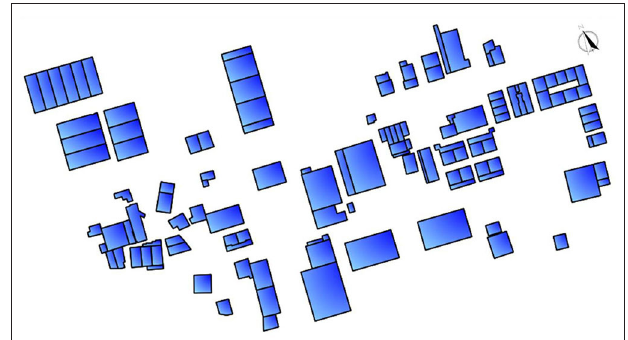
FIGURE 2 | Topological configuration of the modeled district.